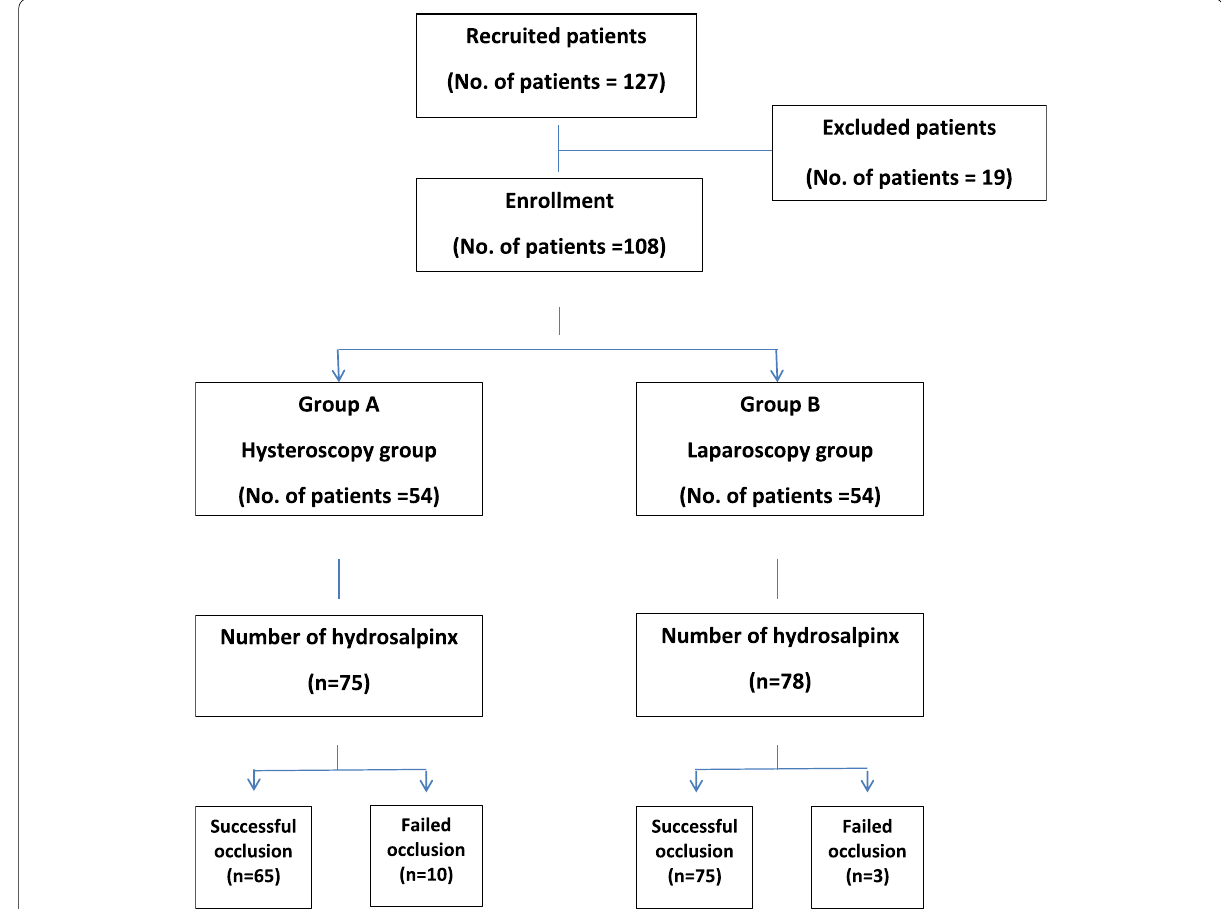
Fig. 1 Flow of patients in the